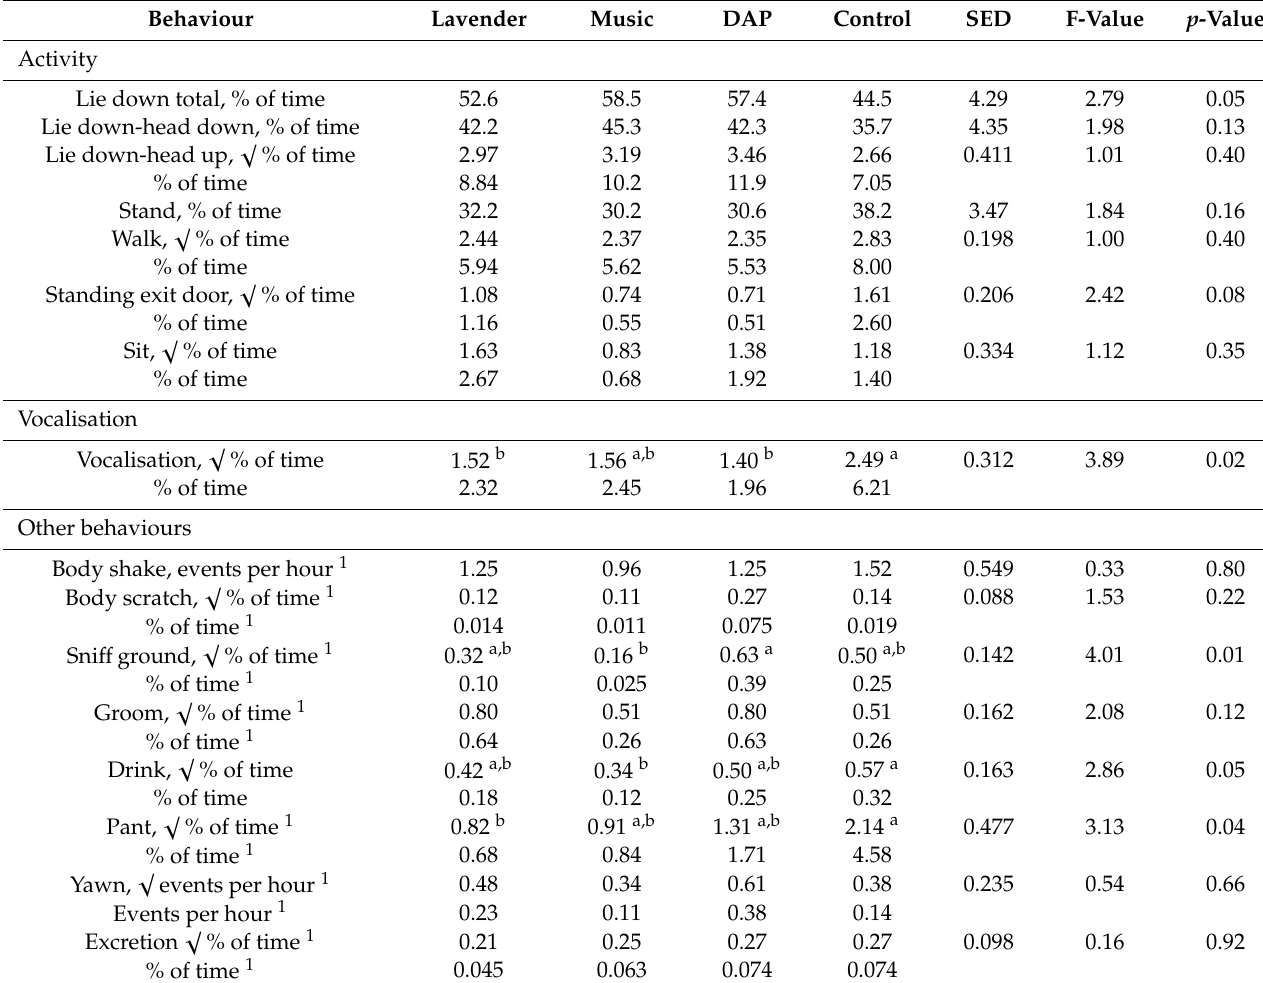
Table 3. The behaviour of dogs ( n = 60) exposed to Lavender, Music, DAP or a Control treatment during the post-treatment period.